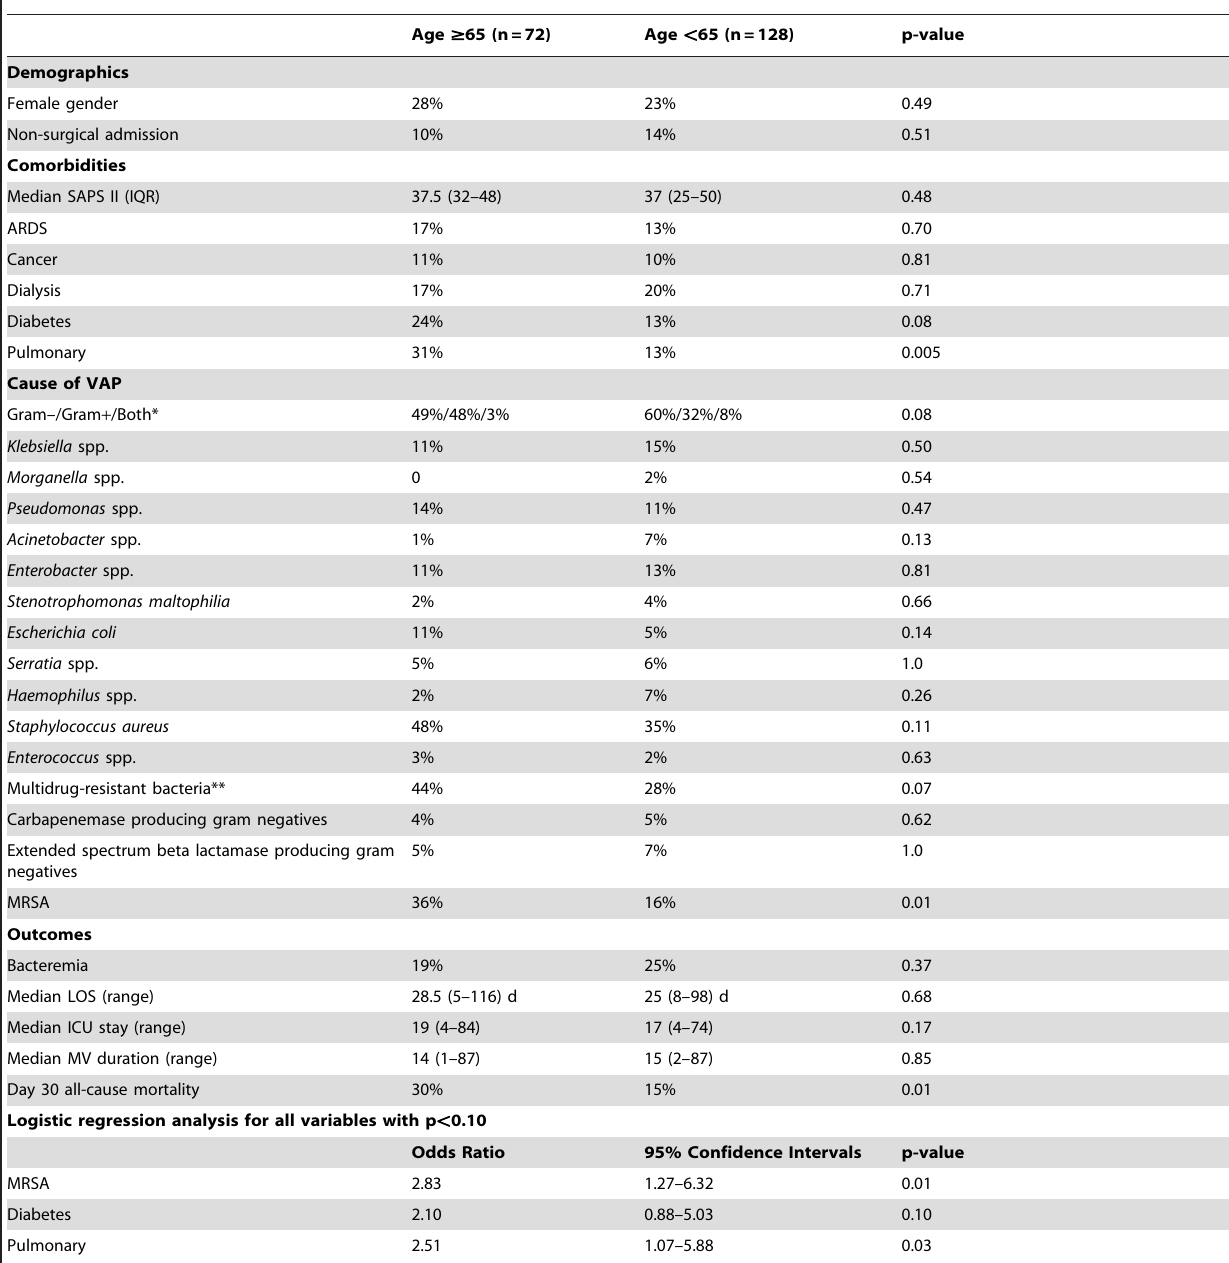
Table 3. VAP patients stratified by